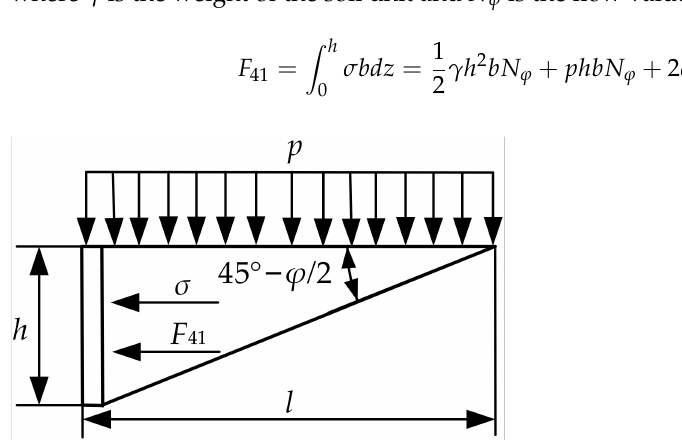
Figure 7. Schematic diagram of the force on the